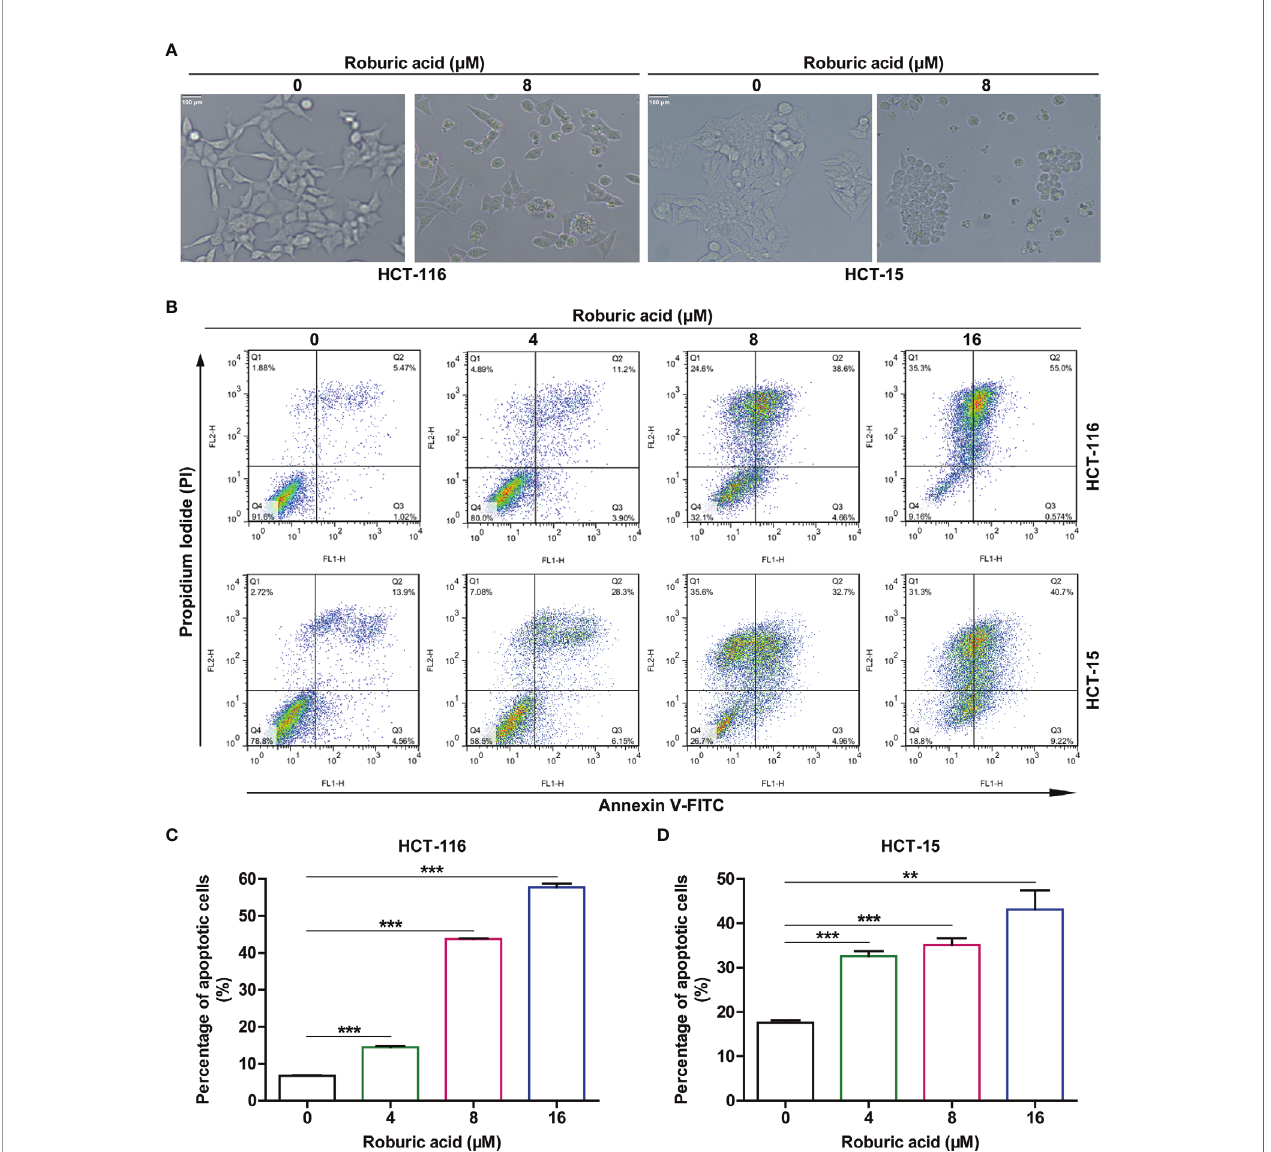
FIGURE 4 | Roburic acid induces apoptosis in HCT-116 and HCT-15 cells. (A) The cell morphology of HCT-116 and HCT-15 cells changed markedly after treatment with roburic acid (8 m M) for 24 h (original magni fi cation ×200). (B) HCT-116 and HCT-15 cells were treated with roburic acid (4, 8, or 16 m M) in serum-free medium for 24 h, and then stained with Annexin V – FITC/PI and analyzed by fl ow cytometry. (C, D) The percentages of Annexin V – FITC-positive apoptotic HCT-116 (C) and HCT-15 (D) cells were evaluated using FlowJo software. Representative images are displayed. Data are shown as means ± SEM of three independent replicates. ** P < 0.01 and *** P < 0.001 compared with the